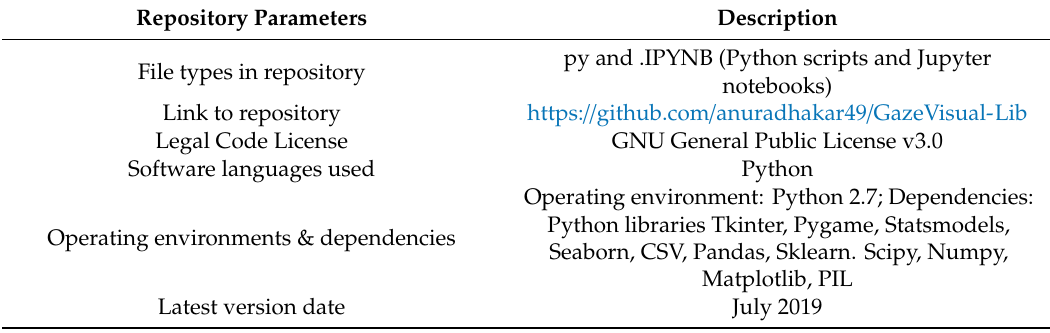
Table 3. Features of GazeVisual-Lib repository.